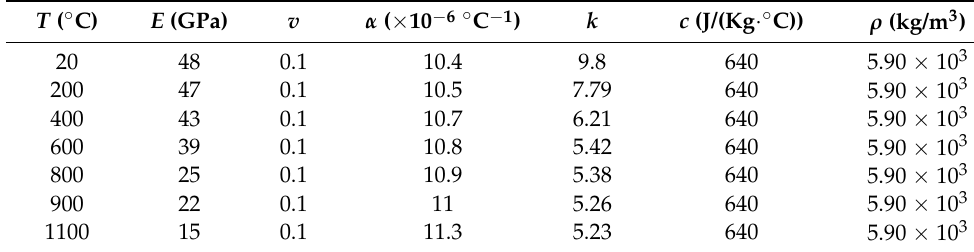
Table 3. Material parameters of 8YSZ for TC3 layer [43–49].